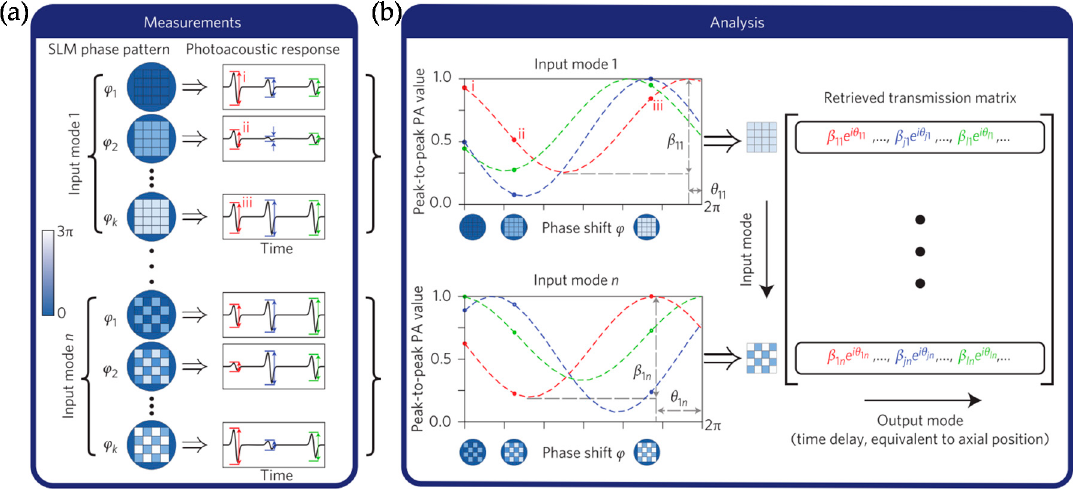
Figure 5. ( a ) The phase of each SLM input mode (in Hadamard basis [84]) is scanned from 0 to 2 π in 16 steps; the corresponding photoacoustic trace is measured for each phase step; ( b ) the peak-to-peak amplitude of each PA signal window closely follows a cosine modulation as a function of the phase of an input mode; the photoacoustic transmission-matrix elements are retrieved directly from these cosine modulation phases θ ij and amplitudes β ij for all input–output mode pairs j , i . The matrix